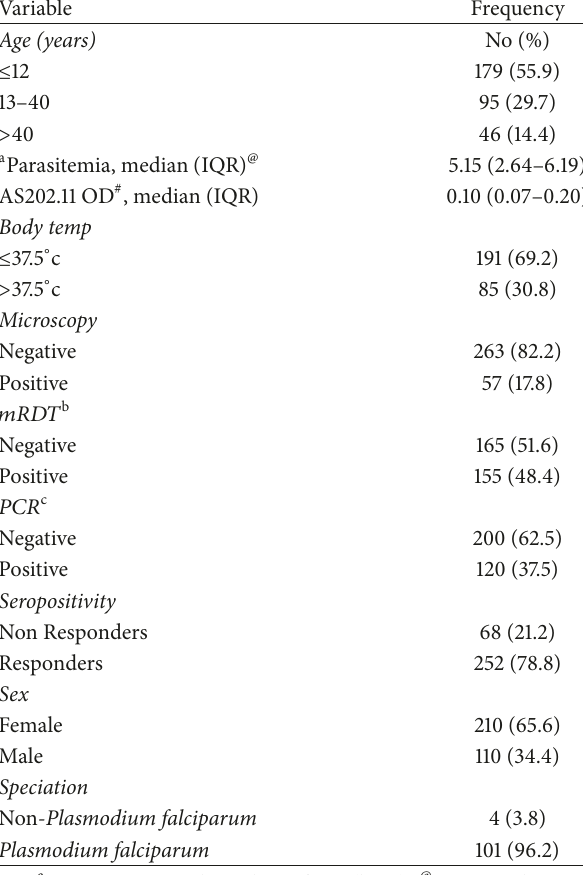
Table 1: Description of study population and frequencies of mea- surements (𝑛 = 320) .